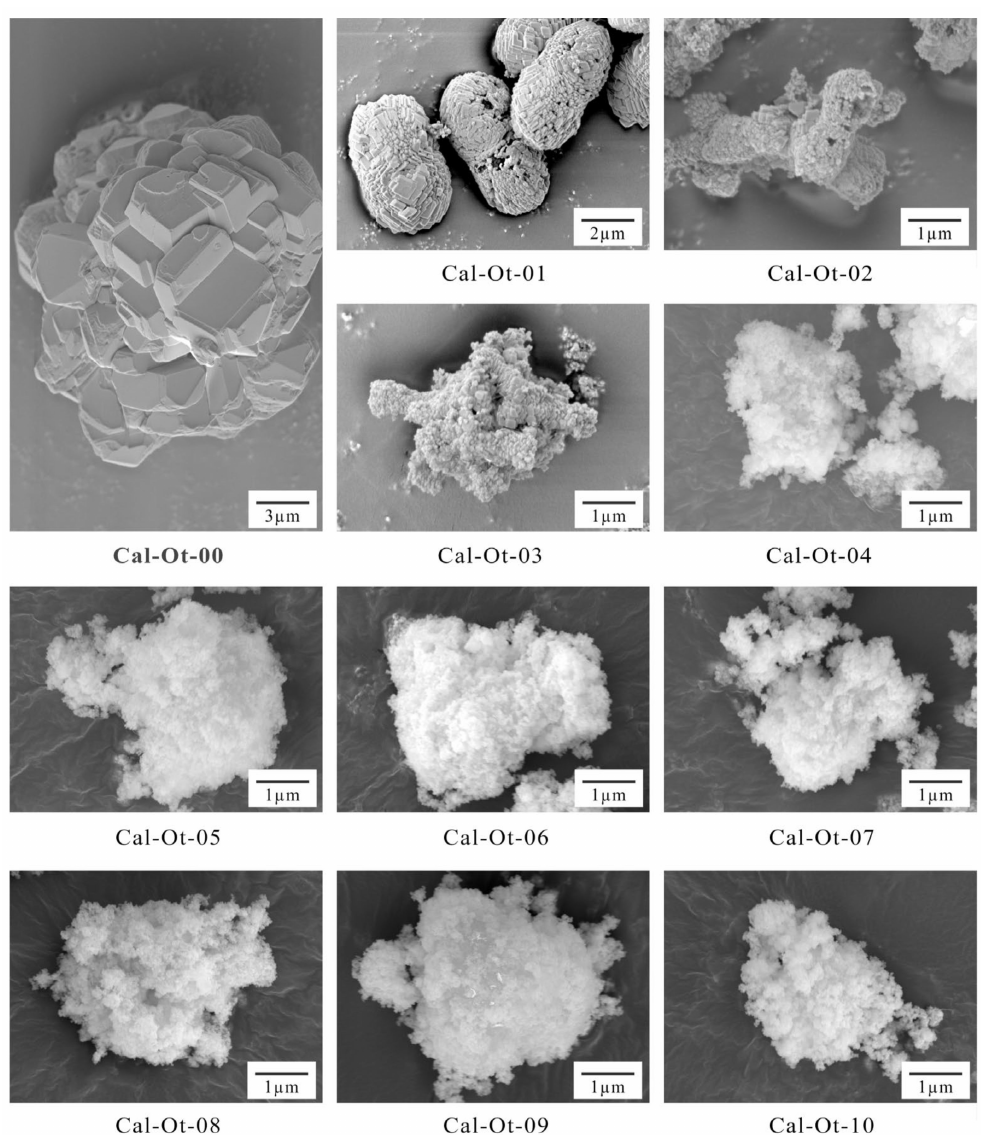
Figure 3. SEM images of the (Ca 1 − x Cd x )CO 3 solid solutions after dissolution in the N 2 -degassed water for 270